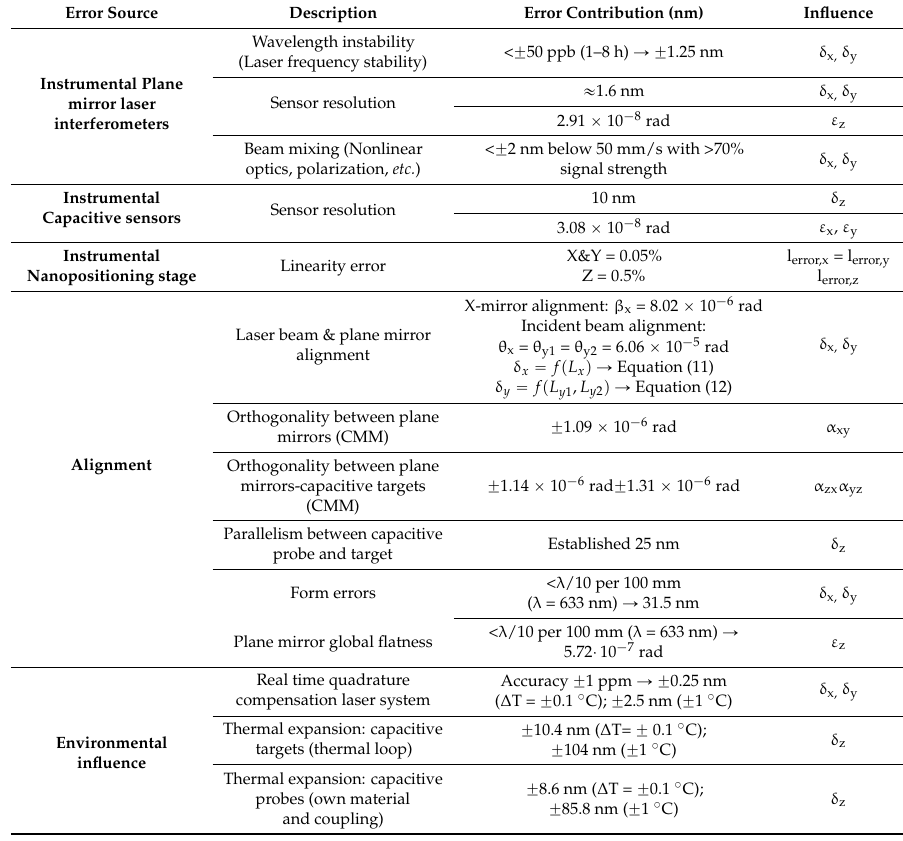
Table 3. NanoPla error budget: summary of the different error sources and their